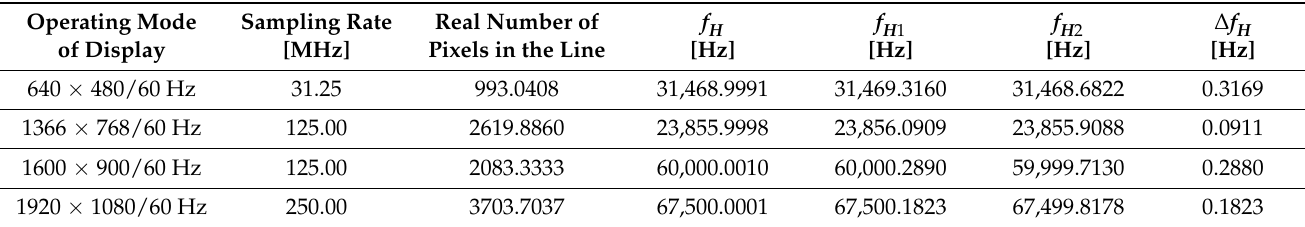
Table 4. Determination of the required spectrum resolution for the FFT.